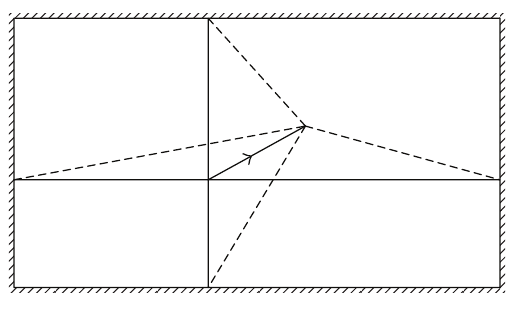
Figure 2: Plate subjected to out-of-plane deformation.